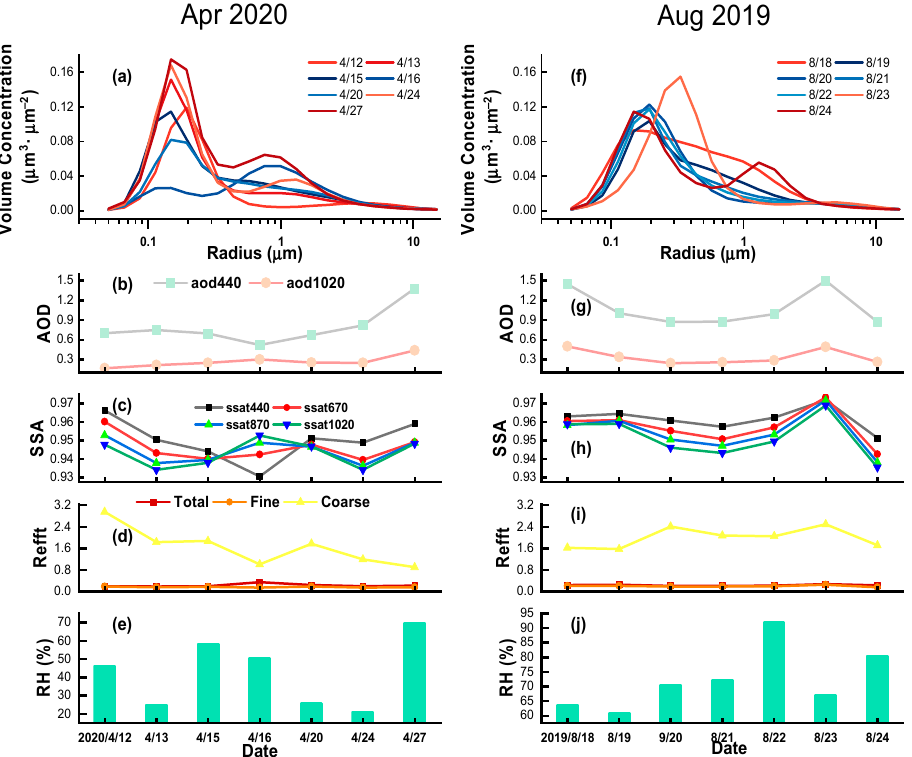
Figure 7. Daily average variation in critical aerosol optical properties of VSD ( a , f ), AOD ( b , g ), SSA ( c , h ), effective radius ( d , i ), and RH ( e , j ) during the two episodes. Note that the y -axes of relative humidity (i.e., ( e , j )) for the two episodes are different in scale.